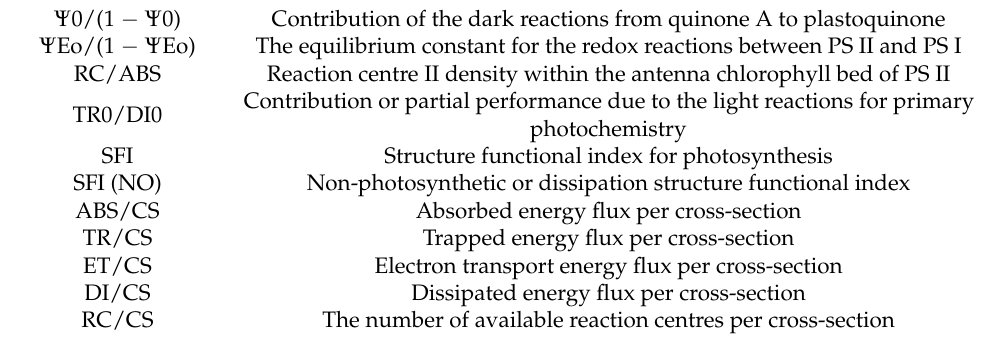
Table 2. Summary of fluorometric analysis parameters and their